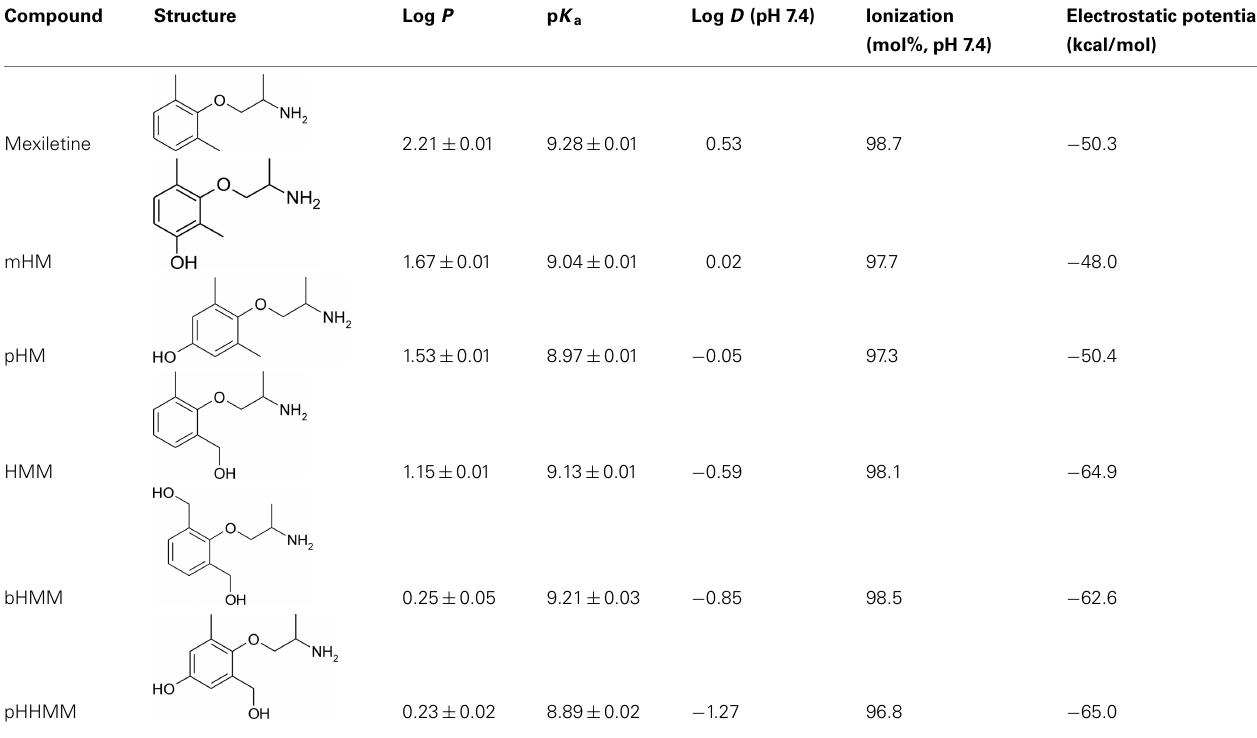
Table 1 | Chemical structures and physicochemical